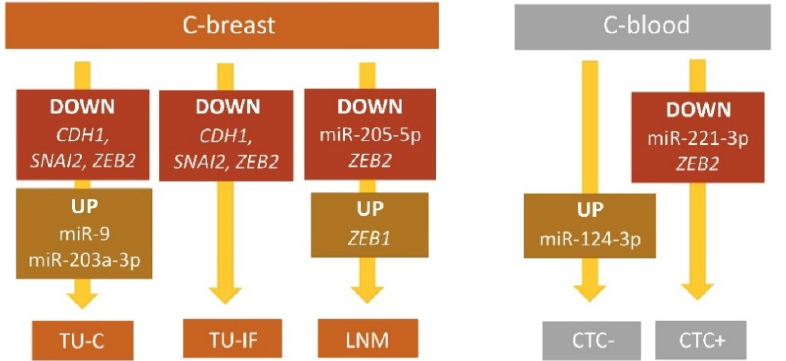
Figure 2. Significantly different expressions of miRNAs and mRNA of CDH1 and EMT genes in tumor centrum (TU-C), tumor invasive front (TU-IF) and lymph node metastasis (LNM), and in CD45-DB fractions enriched by CTCs compared to adequate controls (C-breast, non-neoplastic breast tissues and C-blood, CD45-depleted fractions from healthy women). Table 1. Comparison of miRNA and mRNA of CDH1 and EMT gene expressions between controls and different types of BC patients’ specimens and between each other’s samples.